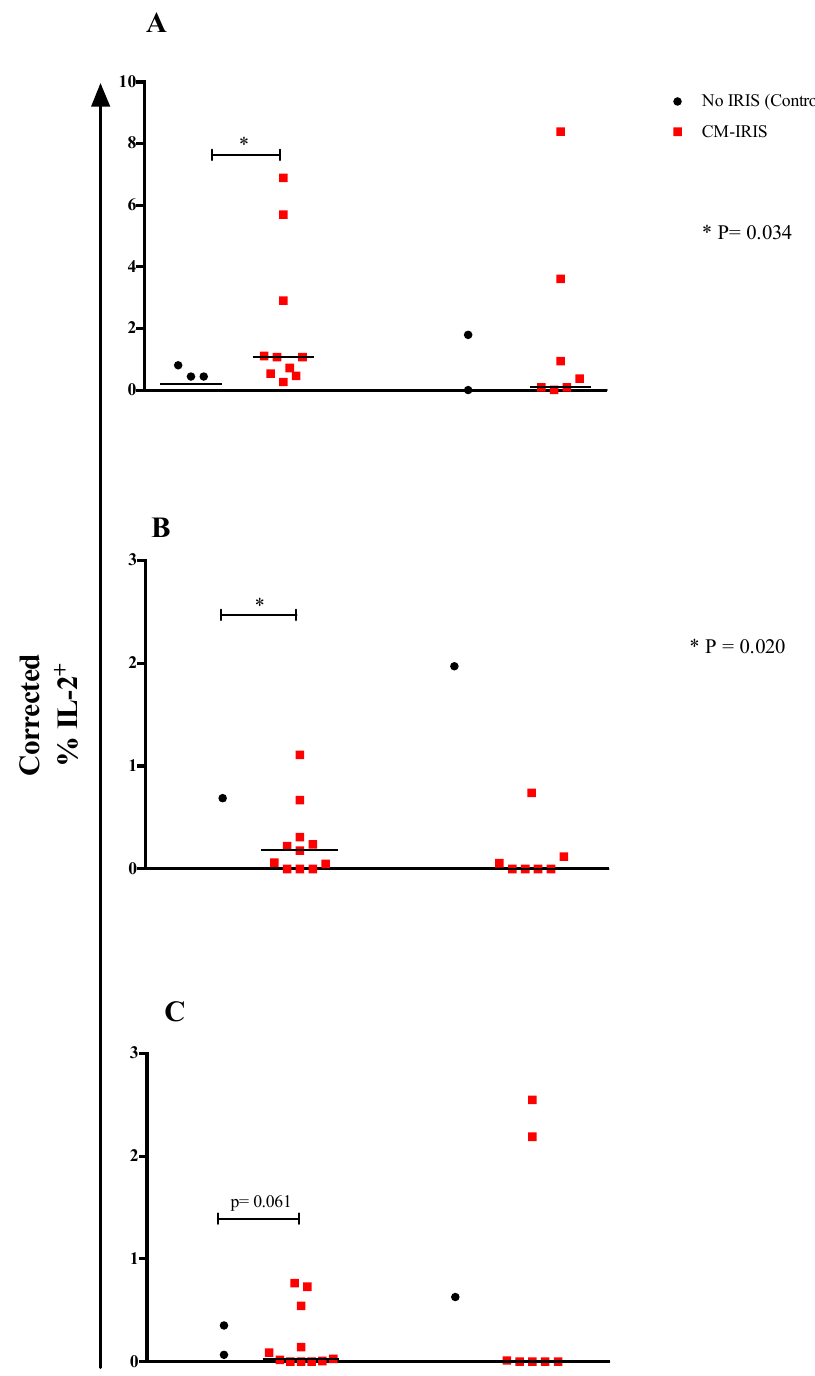
Figure 3. Corrected IL-2 responses by total CD8 + T cells ( A ), naïve CD8 + T cells ( B ) and CD8 + TDEM T cells ( C ) were calculated by subtracting the value for unstimulated samples from the value for mitogen- or IFN- γ -stimulated samples of subjects who developed CM-IRIS compared to controls at baseline. Negative corrected values were reported as zero. Individual responses are shown with the median as a black horizontal line. p -values were determined using the Mann Whitney U test.